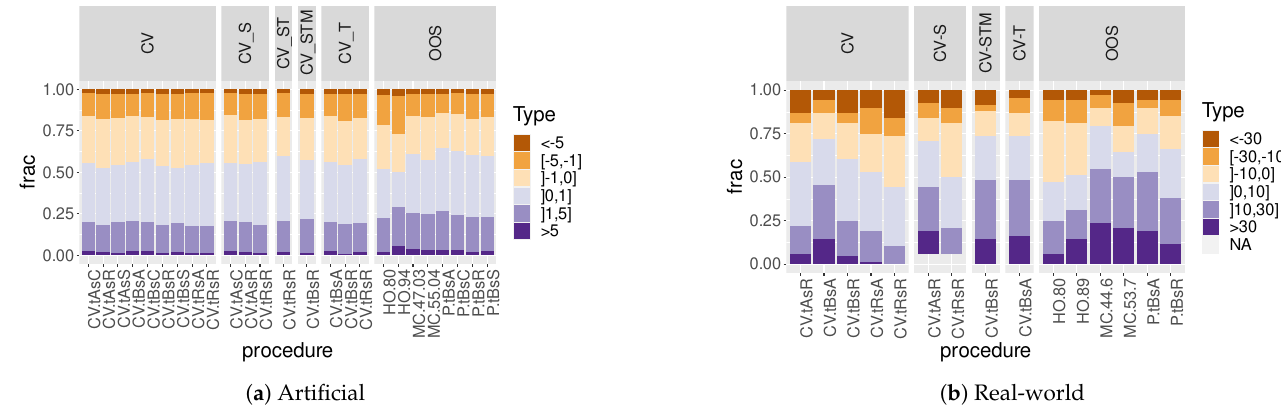
Figure 13. Bar plots of relative estimation errors incurred by cross-validation and out-of-sample procedures on 192 artificial and 17 real-world datasets using two learning algorithms. Note the different